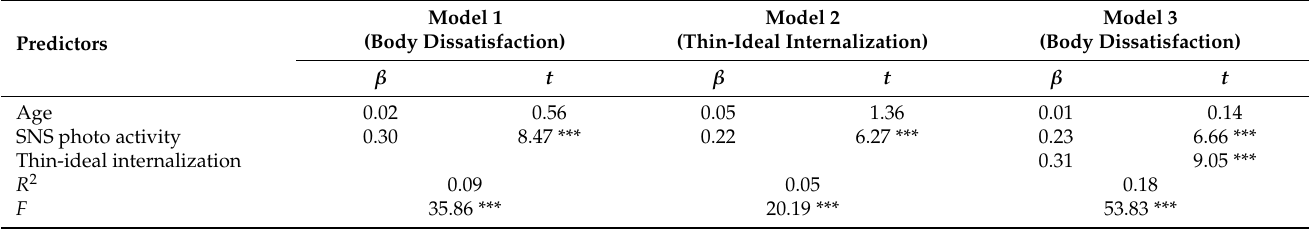
Table 2. Testing the mediation effect of selfie-viewing on body